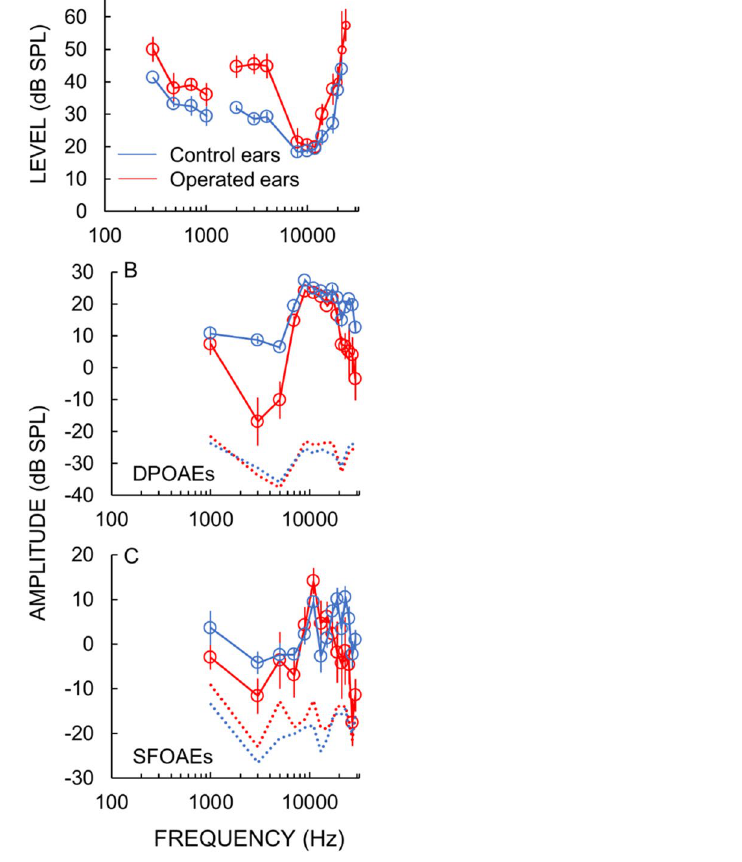
Figure 3. Measurements of hearing function made from control ears (blue) and operated ears (red) before the apical perfusion. ( A ) Hearing threshold measurements were made with the Auditory Nerve Overlapped Waveform (ANOW) at low frequencies (≤ 1 kHz) and auditory nerve compound action potentials (CAPs) at frequencies ≥ 2 kHz. ( B ) Distortion product otoacoustic emission (DPOAE) and ( C ) stimulus frequency otoacoustic emission (SFOAE) amplitude measurements were made before the perfusion. Average DPOAE and SFOAE noise floor measurements are shown as dotted